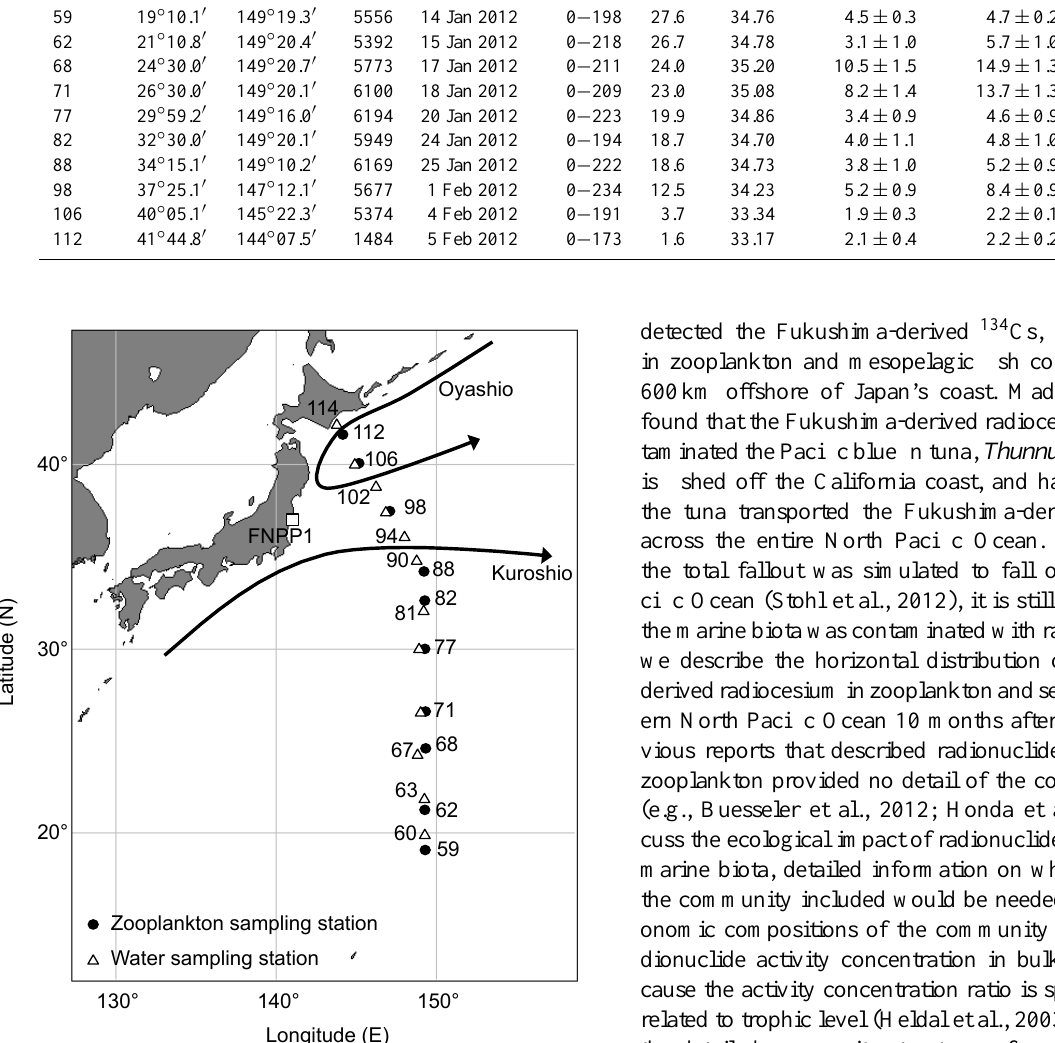
Fig. 1. Sampling locations of zooplankton and seawater samples in the western North Pacific Ocean. Black circles and white trian- gles denote sampling stations for zooplankton and surface seawater, respectively. The Fukushima Dai-ichi nuclear power plant is also shown as a white square in this